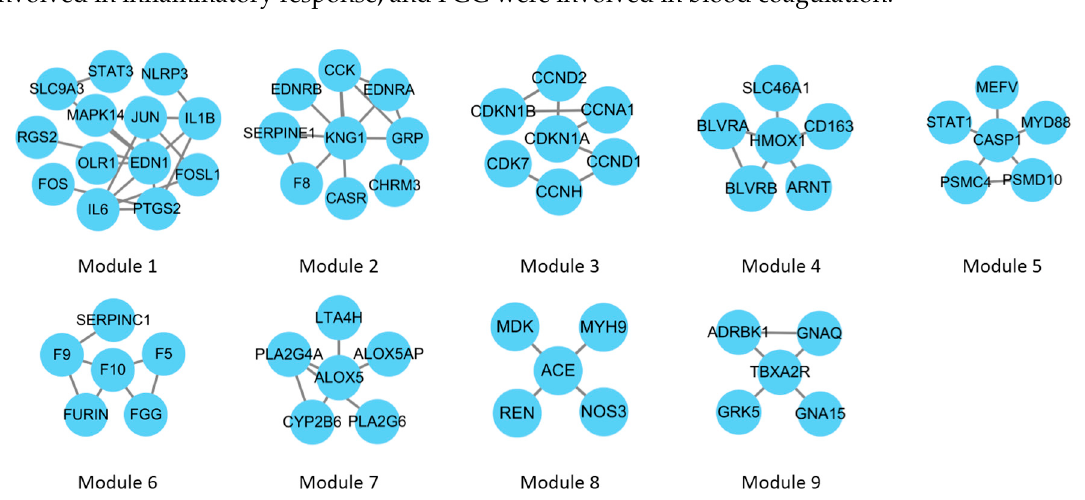
Figure 4. Modules in CHD CePIN. With the fast agglomerate algorithm based on the edge clustering coefficients (FAG-EC) algorithm, nine modules were extracted from the network. Table 5. Gene Ontology (GO) biological process terms of the CHD CePIN modules.